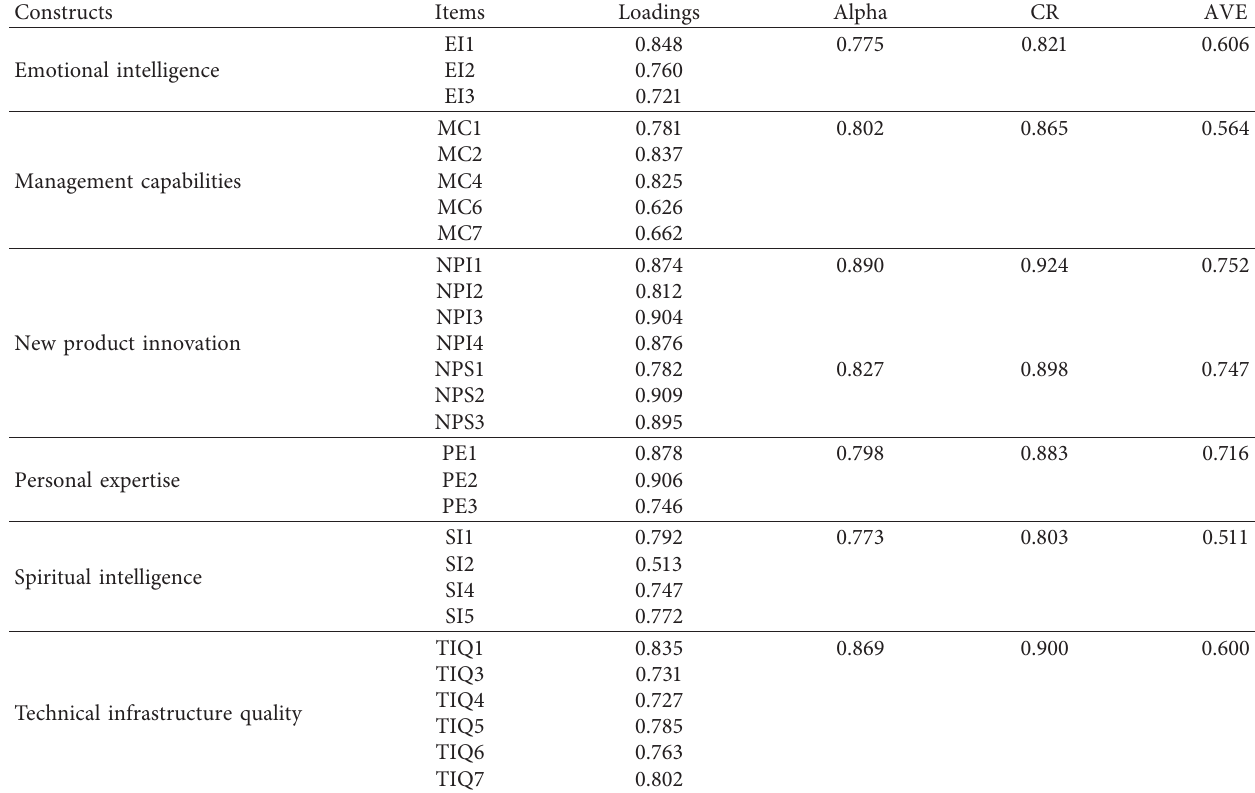
Table 1: Convergent validity.